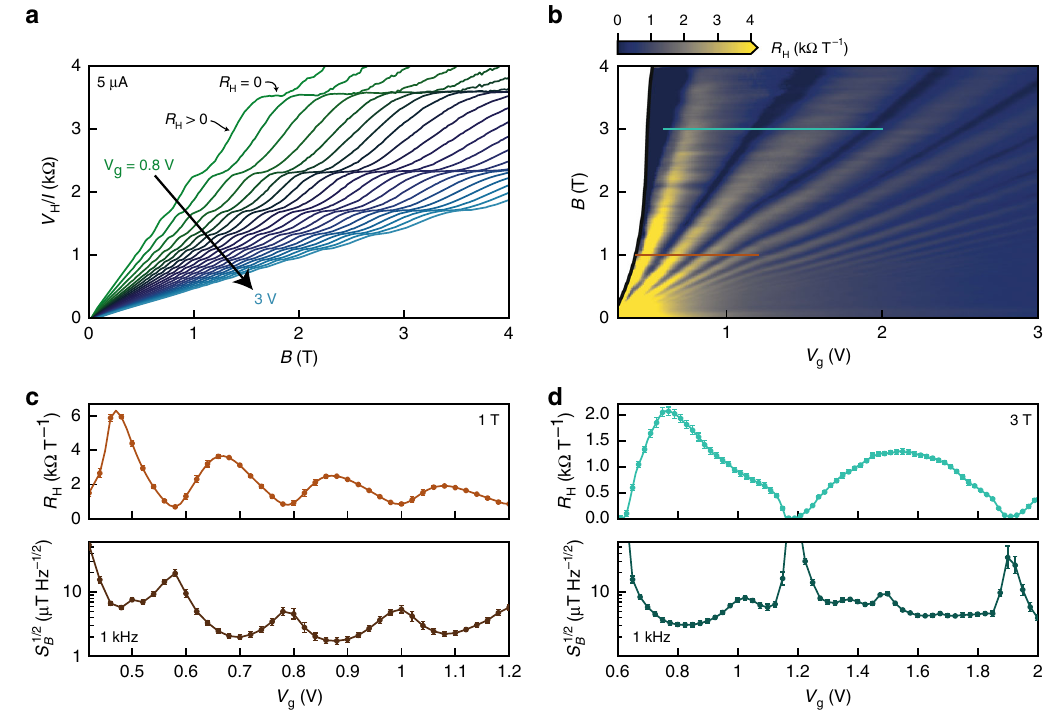
Fig. 5 Performance in large background magnetic fi eld. a Magnetic fi eld dependence of V H / I in the quantum Hall regime for device G1 at 4.2 K. The curves span gate voltages corresponding to electron density 0.24 – 1.14 × 10 12 cm − 2 at zero fi eld. b R H determined locally at each point ( V g , B ). c , d R H and S B = 1 T, d B = 3 T. Error bars are determined considering the standard error of the linear fi t for R B 1/2 at 1 kHz along the horizontal lines in ( b ): c standard deviation of S V 1/2 in a window of width 200 Hz centered at 1 kHz. All measurements are performed under 5 μ A dc current